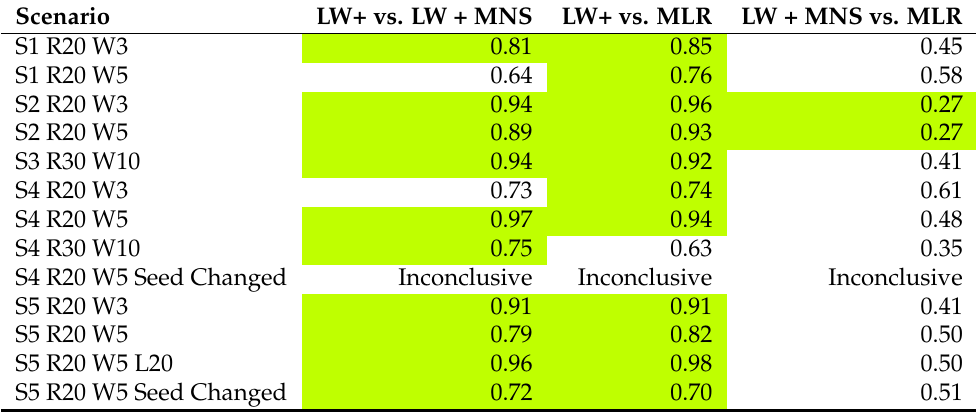
Table 2. Vargha–Delaney A-test scores comparing the various strategies. In each column, the strategy named on the left of the vs is compared to the strategy named on the right. Values above 0.5 indicate slower performance by the strategy on the left; scores below 0.5 indicate the right-hand strategy was worse. Results for scenarios in which statistical significance p -values were below the 5% threshold are marked in